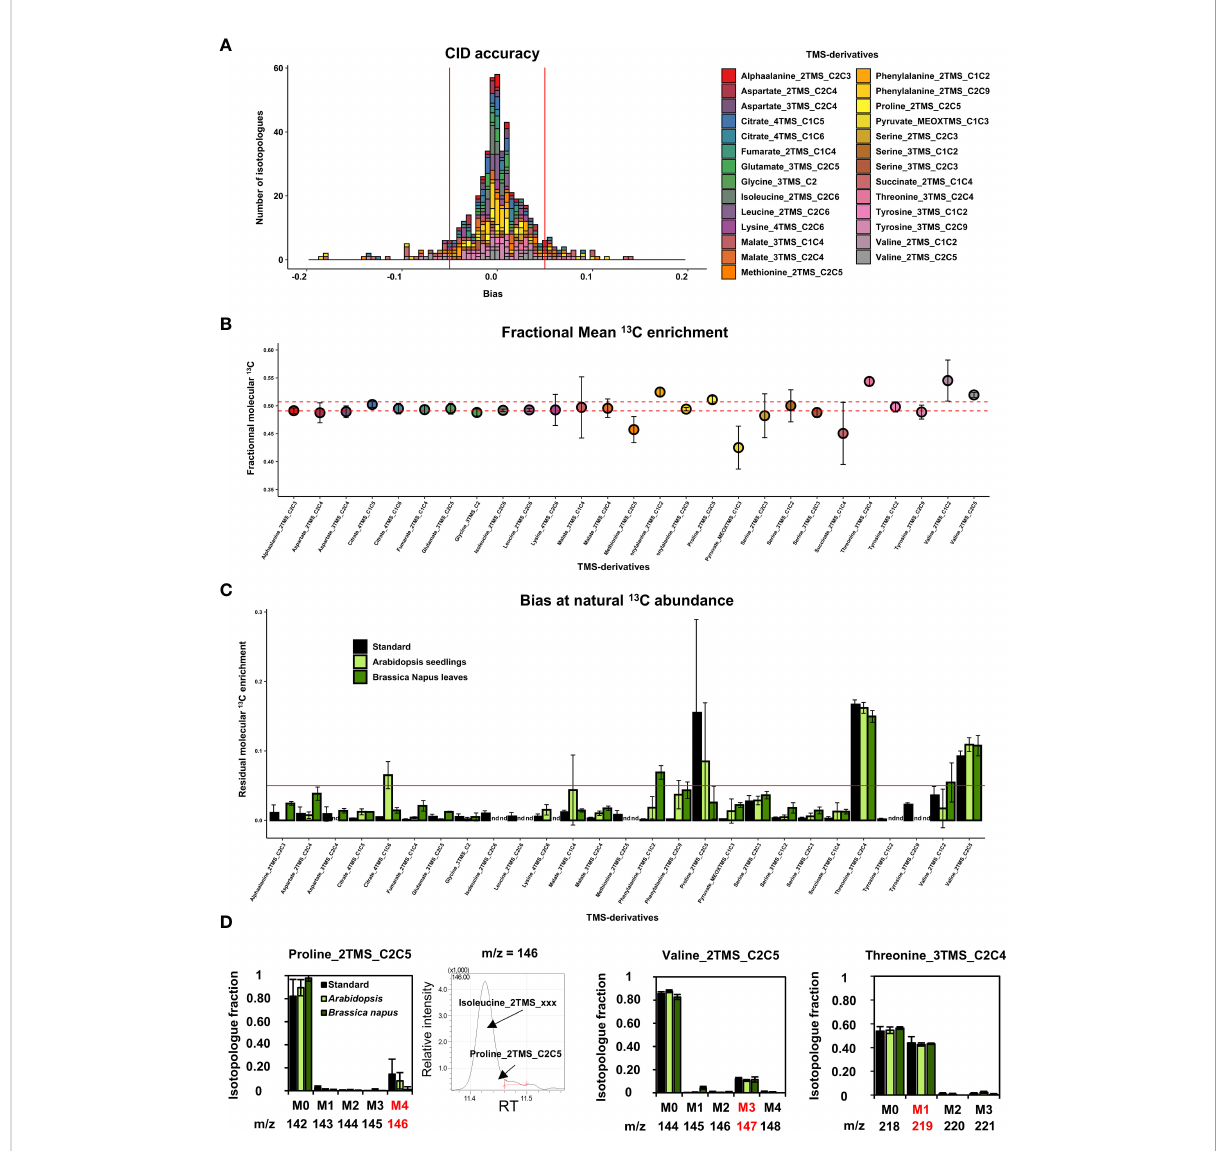
FIGURE 3 Evaluation of the measurement accuracy for CID and mean 13 C enrichment at 13 C-PT and 13 C natural abundance in plants. (A) , CID accuracy and (B) , Mean 13 C enrichment for the selected TMS-derivatives of organic and amino acids using 13 C-PT samples. (C) , Residual mean 13 C enrichment measured in chemical standards, Arabidopsis seedlings and ( B ) napus leaves after correction for isotope natural abundance. (D) , Isotopologue-speci fi c biases identi fi ed at 13 C natural abundance for proline, valine and threonine fragments. The results are presented as the mean ± SD of four independent biological replicates or independent preparations for commercial chemical